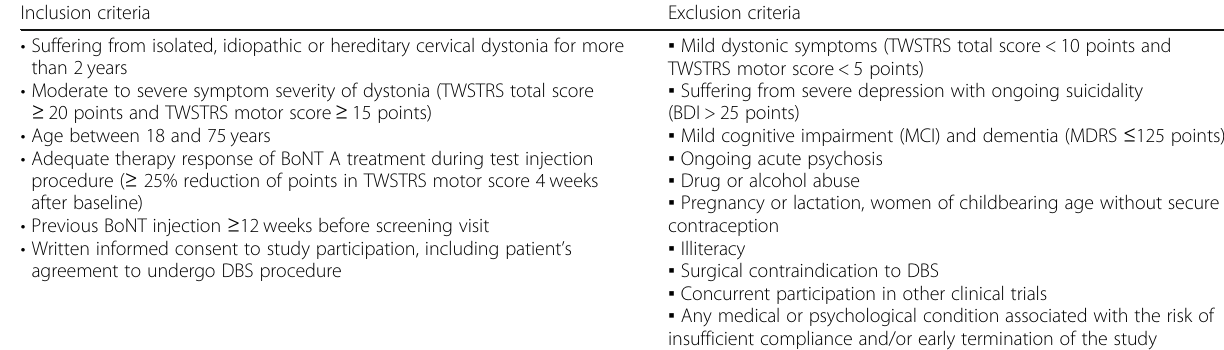
Table 1 Eligibility criteria Inclusion criteria Exclusion